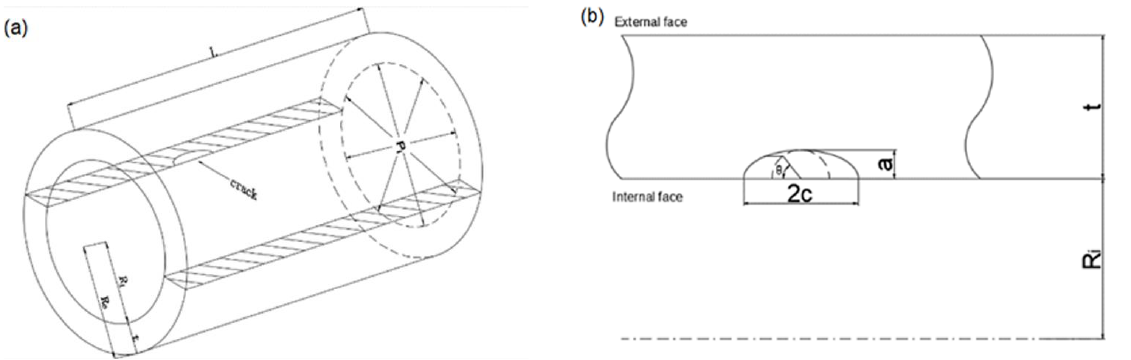
Figure 11. The schematic diagram of ( a ) pressurized pipes with an axial surface crack and ( b ) an axial surface crack.